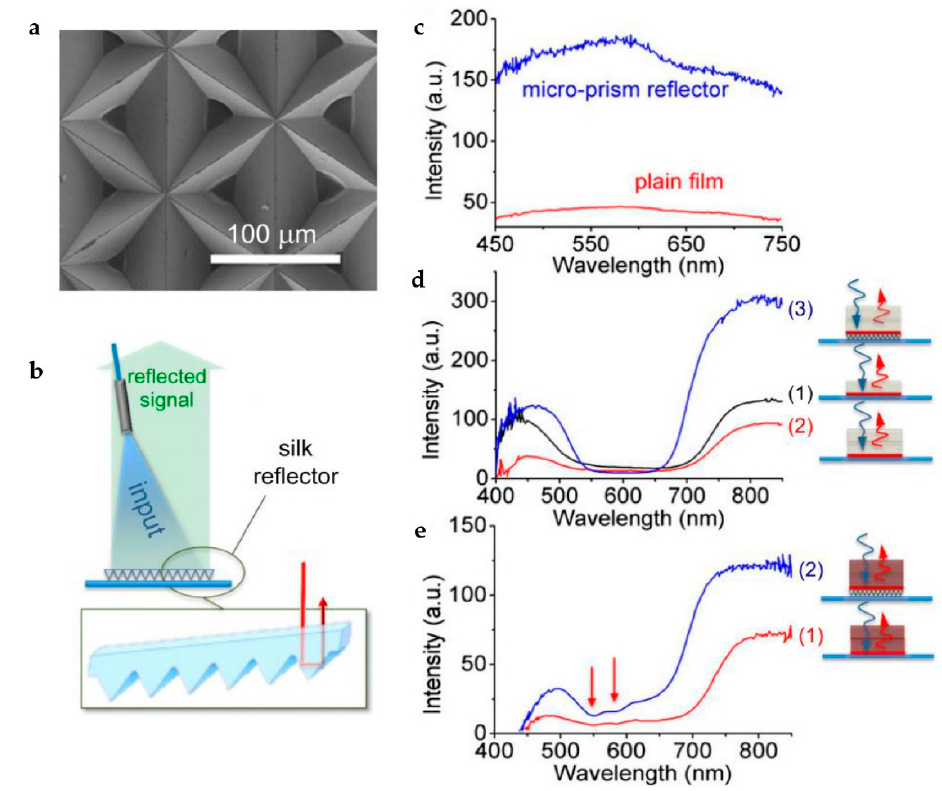
Figure 7. ( a ) Scanning electron microscope image of a typical silk microprism array. ( b ) Schematic illustration of the experimental setup for the measurement of the optical properties of the replicated microprism array. ( c ) Comparison of the reflected signal obtained from a microprism array (blue) and a plain silk film (red). ( d ) The reflected signals obtained from (1) a cellulose layer with red pigment covered with one layer of fat, (2) a cellulose layer with red pigment covered with two layers of fat and (3) a silk microprism array placing under a cellulose layer with red pigment covered with two layers of fat. ( e ) The reflected signals obtained from (1) a cellulose layer with red pigment covered with two layers of muscle tissue and (2) a silk microprism array placing under a cellulose layer with red pigment covered with two layers of muscle tissue. ( a – e ) Reproduced with permission from [21].